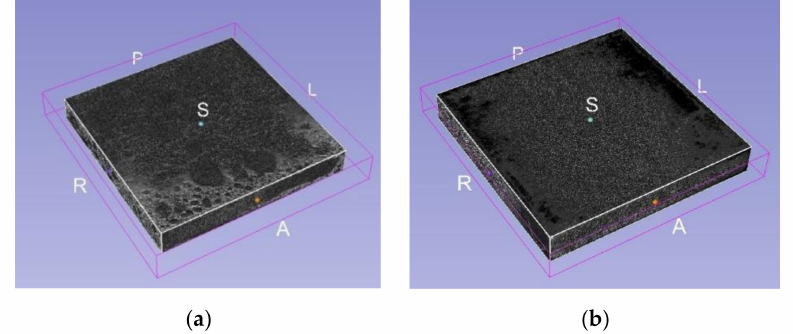
Figure 3. 3D model of the stacked CT images of Aluminium Foam sample A1 ( a ) & A2 ( b ) (40 × 40 × 5